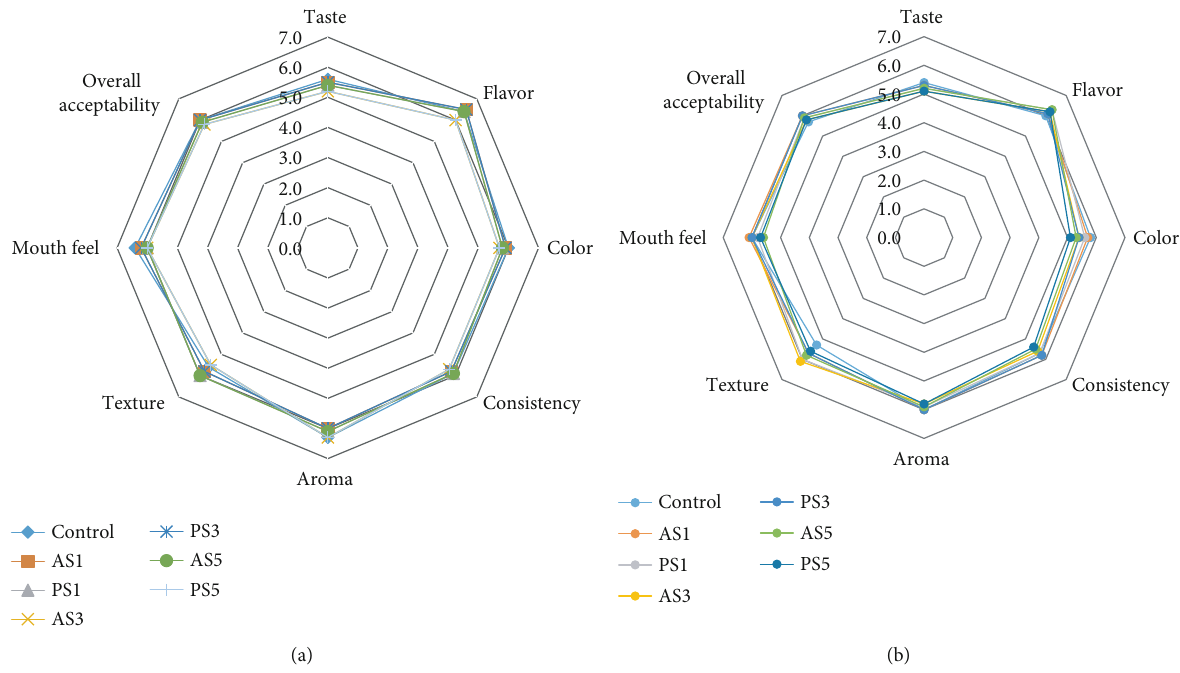
Figure 1: Sensory acceptability of pineapple juice. (a) Initial day. (b) Stored for 7 days. Control: pineapple juice (without starch); AS1: 1% anchote starch; AS3: 3% anchote starch; AS5: 5% anchote starch; PS1: 1% potato starch; PS3: 3% potato starch; PS5: 5% potato